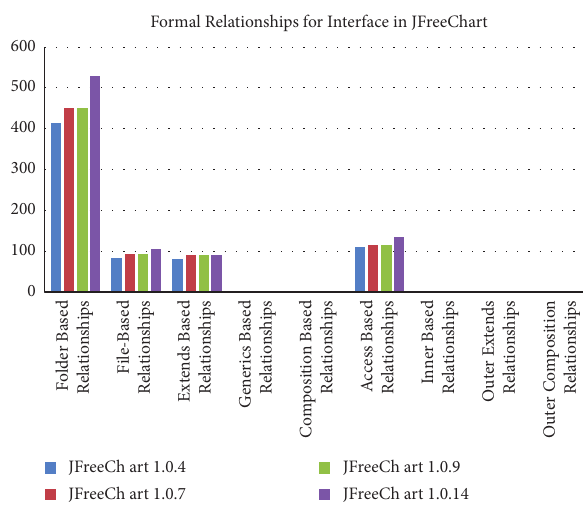
Figure 12: Count number of formal relationships for interface in JfreeChart.